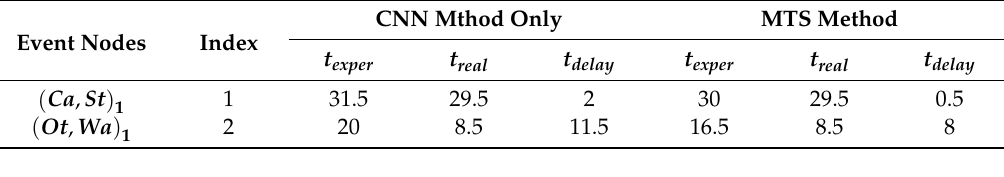
Table 8. Basic SE of (cid:104) Ca : Wa (cid:105) Table 8. Basic SE of < (cid:1829)(cid:1853): (cid:1849)(cid:1853) > (cid:2869) . Table 8. Basic SE of < (cid:1829)(cid:1853): (cid:1849)(cid:1853) > (cid:2869) .